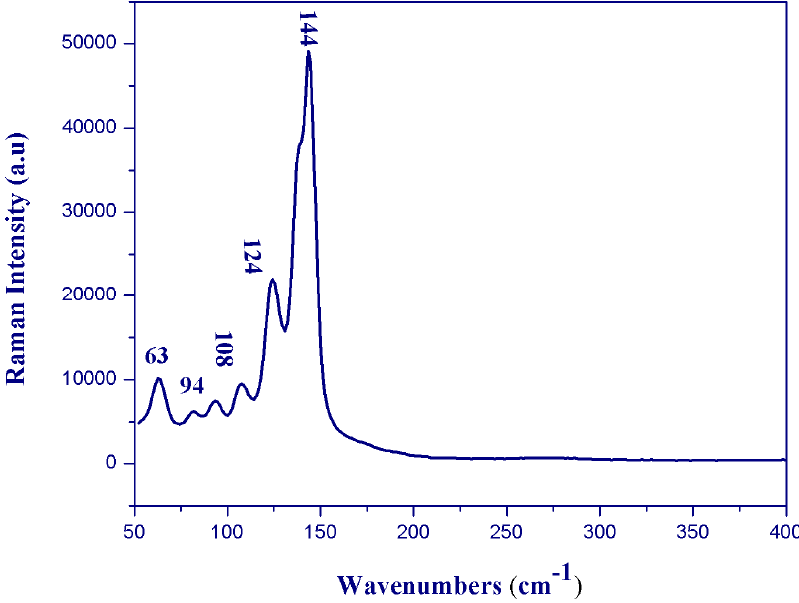
Figure 10. Raman spectrum of Bi 4 I 16 ·4(C 6 H 9 N 2 )·2(H 2 O).